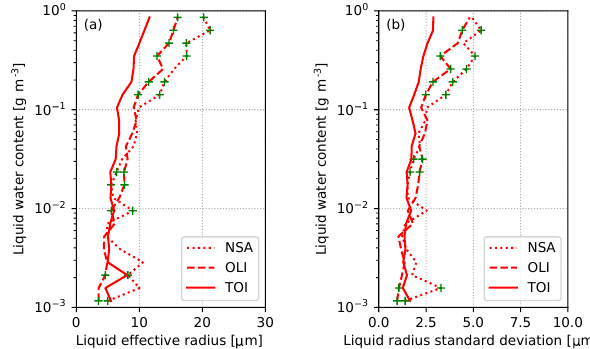
Figure 5. (a) Mean r eff and (b) mean SD as a function of LWC for the data presented in Fig. 4. The green crosses indicate a significant difference between OLI and NSA (5% confidence